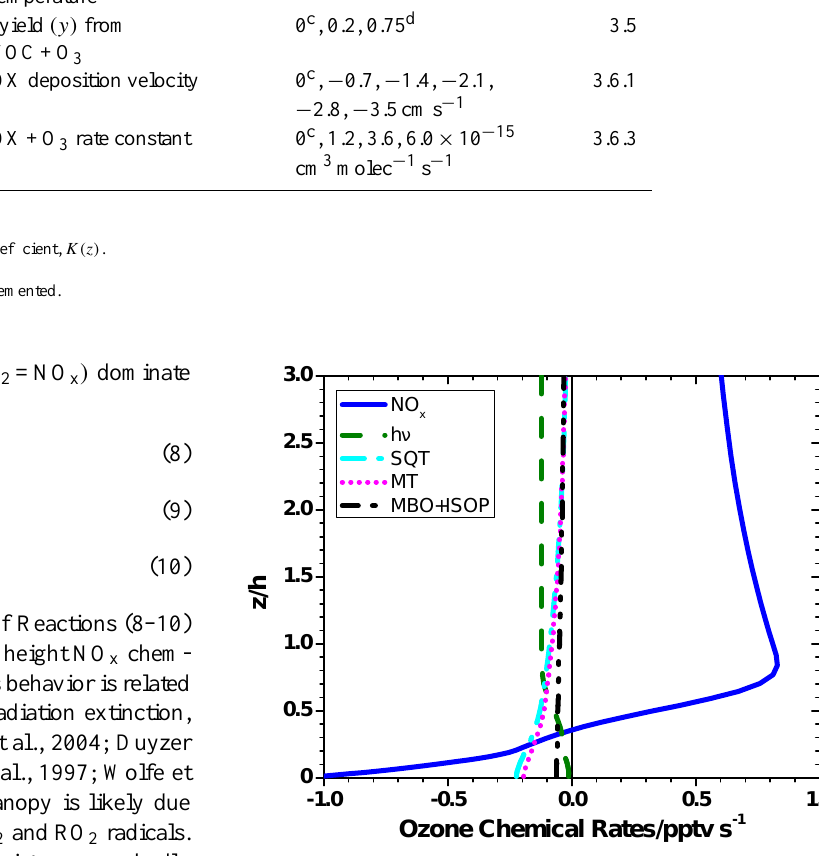
Fig. 1. Vertical profile of contributions to chemical production and loss of ozone for the base scenario. The “NO x ” profile represents the sum of rates for the NO+O 3 reaction and NO 2 photolysis. The “ hν ” profile represents the net loss of ozone from photolysis after accounting for the branching of O( 1 D) reactions between quenching and reaction with water